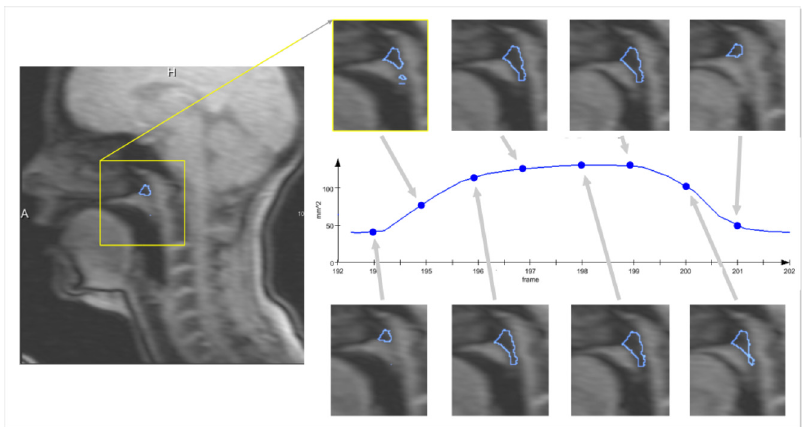
Fig 2. Mid-sagittal RT-MRI images of the vocal tract for several velum positions, over time, showing evolution from a raised velum, to a lowered velum and back to initial conditions. The presented curve, used for analysis, was derived from the